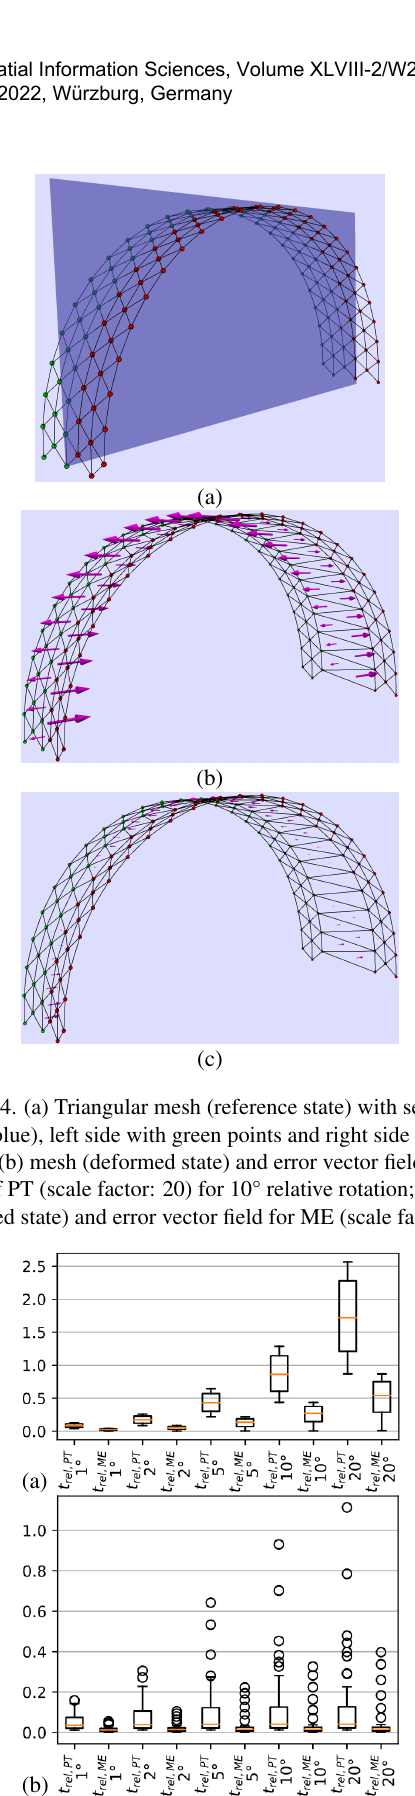
Figure 15. (a) Boxplots of absolute errors; (b) boxplots of relative errors for different relative rotation